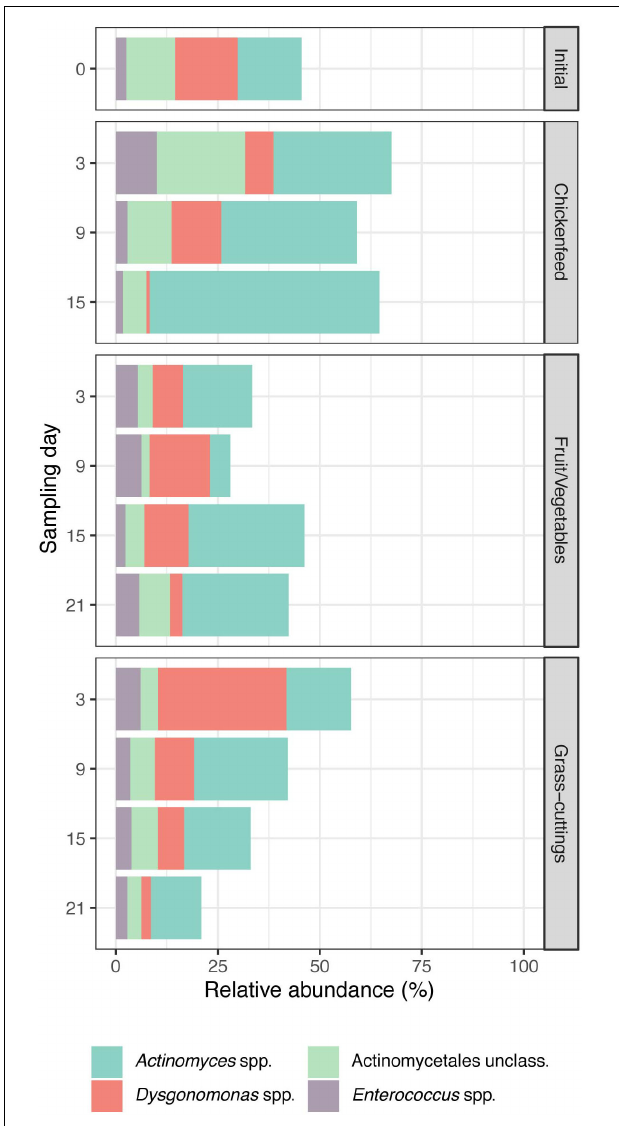
FIGURE 7 | Relative abundances of OTUs identified as bacterial core community in the guts of Black Soldier Fly larvae and present in at least 80% of all samples ( n = 3). Together, they account for approximately half of the reads generated during